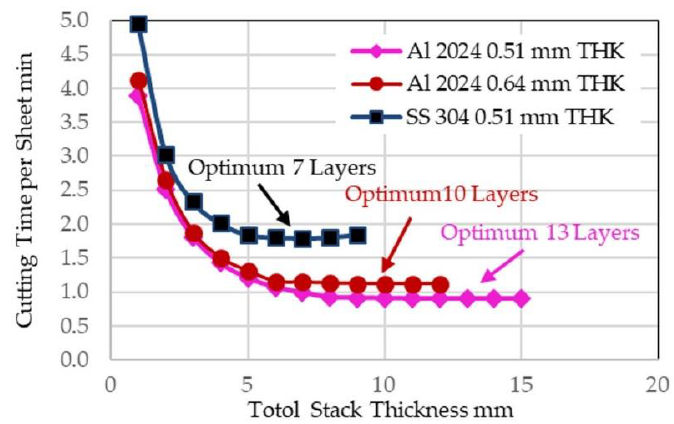
Figure 23. Typical optimum stack heights for two metals.